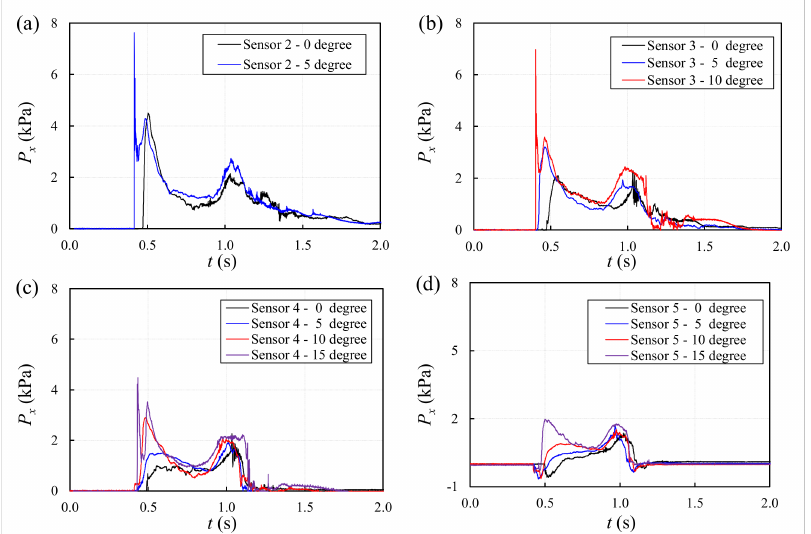
Figure 8. Comparison of the dynamic pressure from transducers at same level: ( a ) transducer 2 in 0- and 5-degree cases; ( b ) transducer 3 in 0-, 5-and 10-degree cases; ( c ) transducer 4 in 0-, 5-, 10-and 15-degree cases; ( d ) transducer 5 in 0-, 5-, 10- and 15-degree